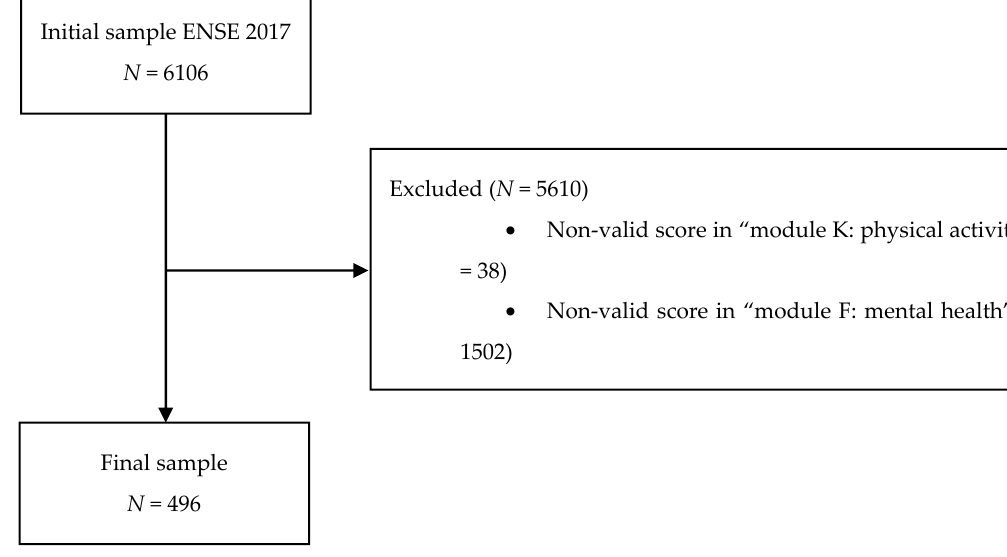
Figure 1. Sample selection process.